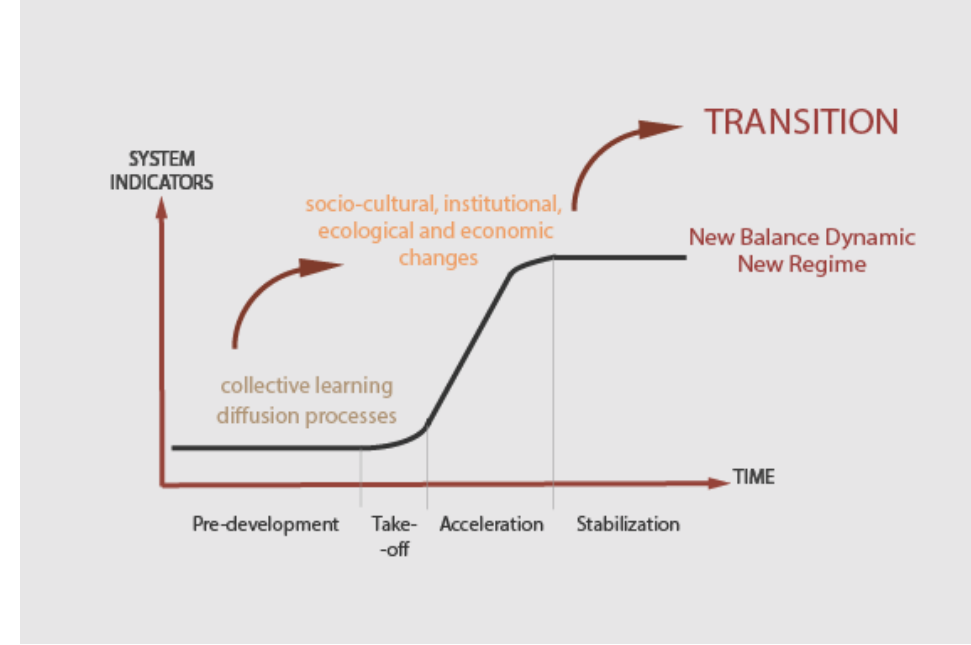
Figure 6. Multiphase concept. Elaborated by the authors based on Van den Bosch ([28], p. 42) and Rotmans et al. ([50], p. 17).